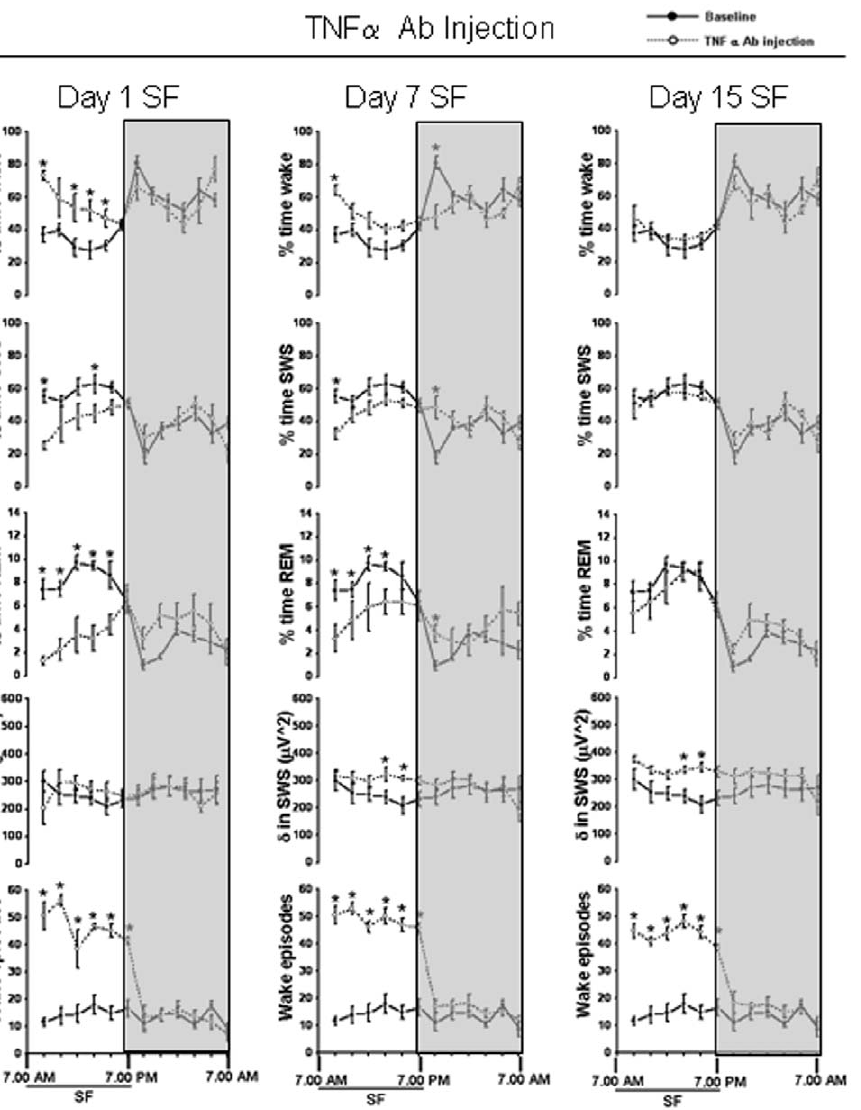
Figure 5. Sleep-wakefulness, EEG delta power in SWS and wake episodes (2 hr bins) in TNF- a antibody injection mice. Comparison of sleep parameters in TNF- a antibody injection mice at baseline (solid line represents baseline values in the respective group), day 1, day 7 and day 15 of SF (dashed line represents SF values in the respective group). Shaded area represent dark period. The black line indicates SF period (7.00 am to 7.00 pm). SF, sleep fragmentation. p , 0.05. *=comparison between baseline and SF during respective post-fragmented days.